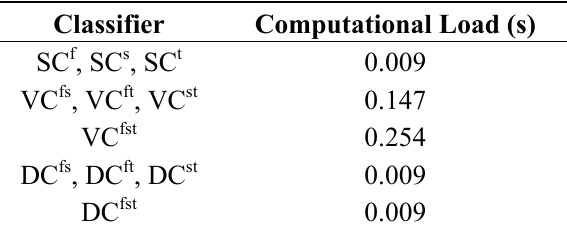
Table 3. Means of Computational Load.